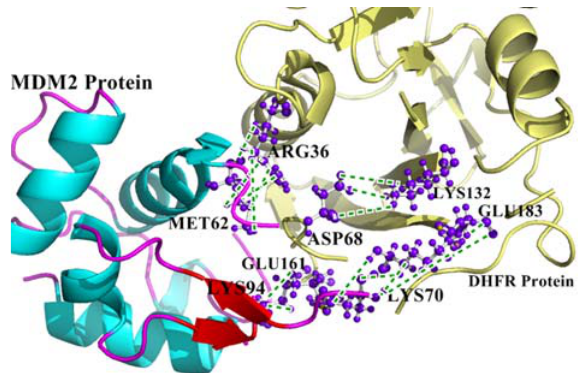
Figure 2: Few interactions in the final simulated and refined MDM2-DHFR protein complex in Homo sapiens . The residues are labelled with purple-blue “ball and stick” representation and the interactions are depicted in green dashed lines.